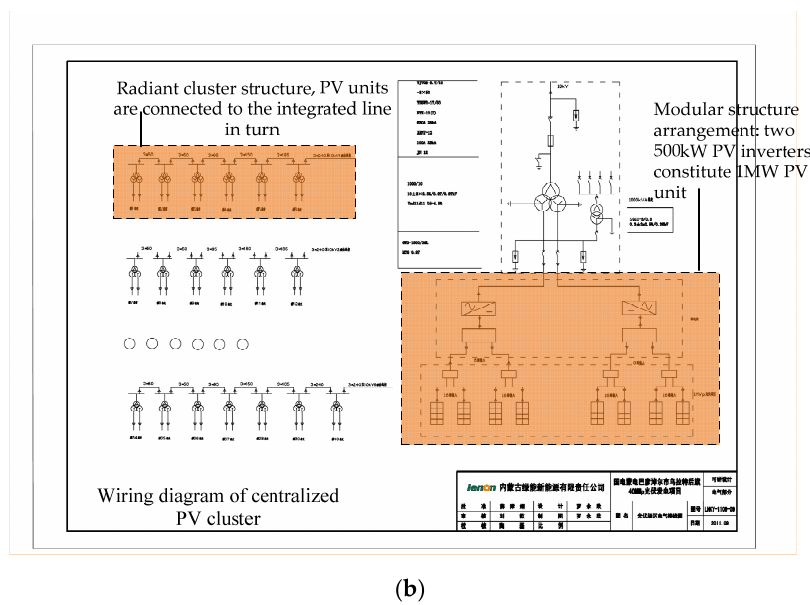
Figure 1. Take the centralized PV cluster in Bayannur city of Inner Mongolia province as an example to describe. ( a ) Electrical wiring diagram of boost station; ( b ) Wiring diagram of centralized PV clusters. Abbreviations: PV, photovoltaic; PCC, point of common coupling.